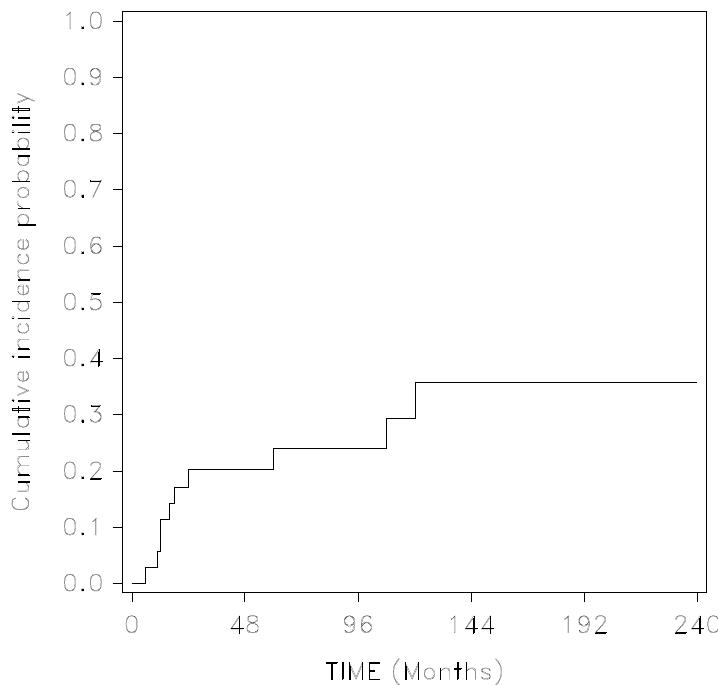
Figure 2. Cumulative incidence probability of recurrence rate after surgical treatment of umbilical endometriosis.